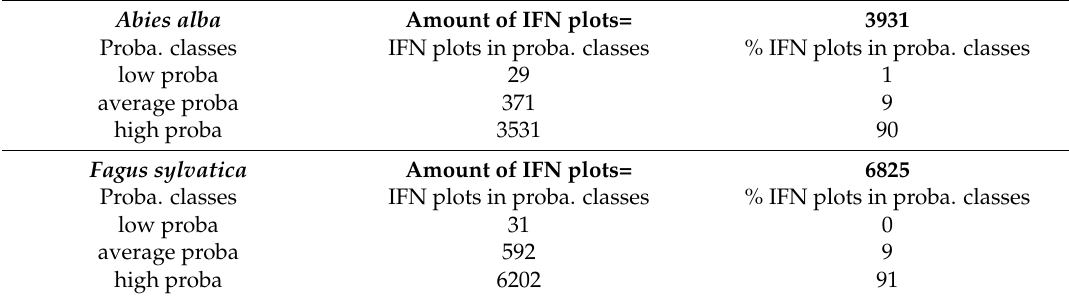
Figure 2. Comparison of the maps of the potential suitable areas of five tree species with their observed distribution provided by the IFN.